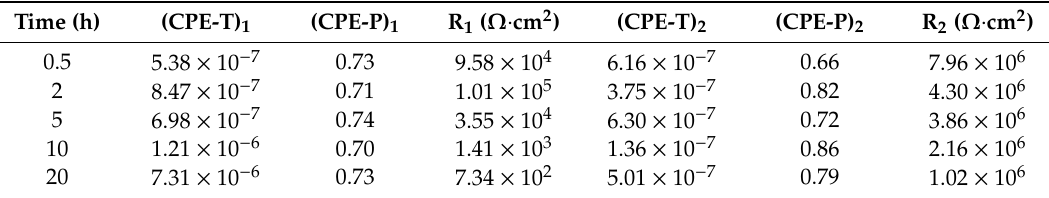
Table 3. EIS fitting results for MAO coating on AZ91 alloy after immersion in 0.1 M NaCl solution for di ff erent